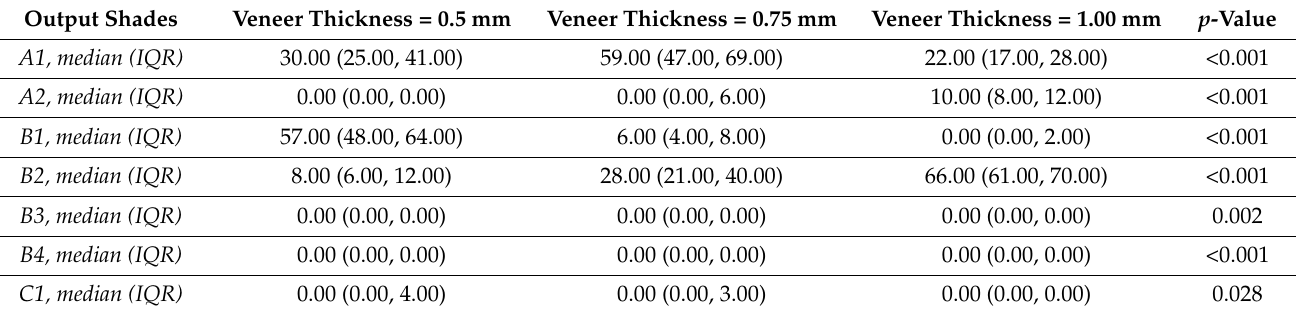
Table 1. Distribution of the percentage of output shades according to veneer thickness. The table shows the results of the Kruskal–Wallis test for multiple comparisons of non-parametric data. 1: